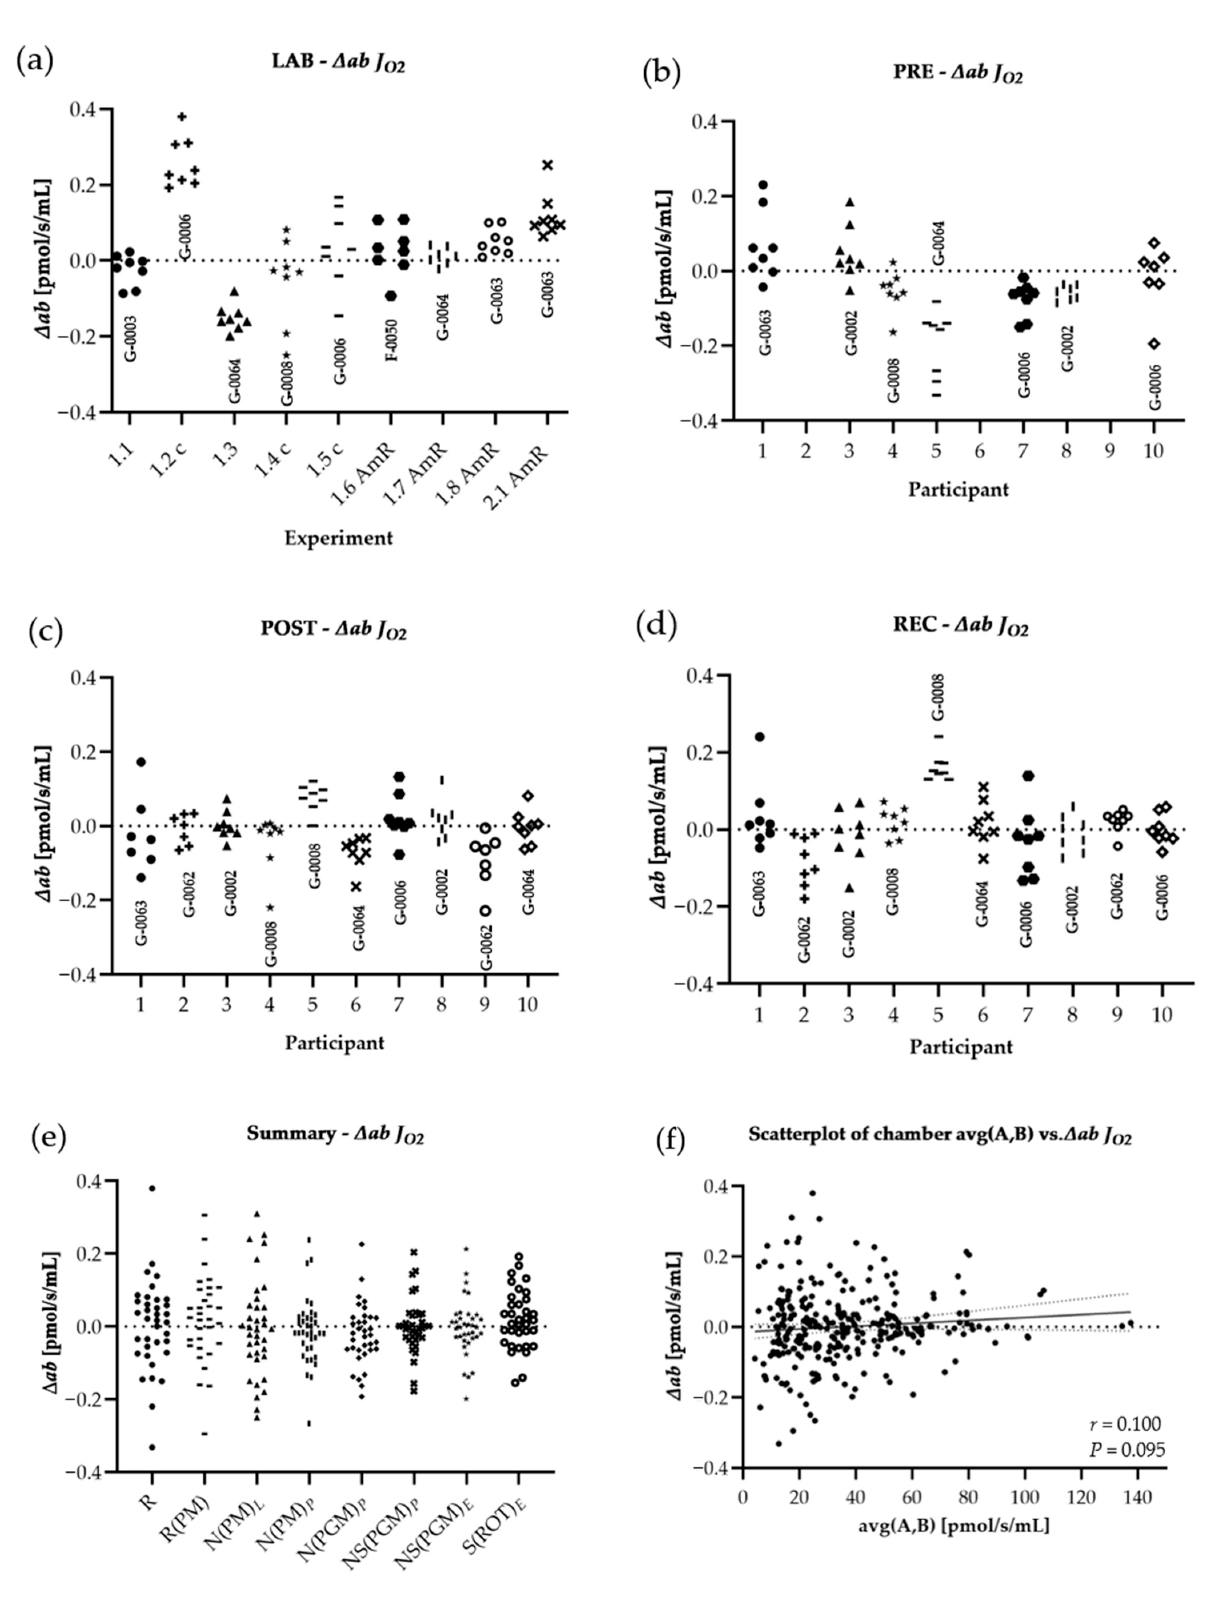
Figure 4. Distribution of variances for J O 2 : The difference of both chambers A and B, divided by the respective chamber average [ ∆ ab = (A − B)/AVG(A,B)], calculated from ROX non-corrected data. Graphs show ∆ ab from experiments performed in the laboratory of Oroboros Instruments ( a ) in field conditions before the ultramarathon race ( b ), right after ( c ) and 24